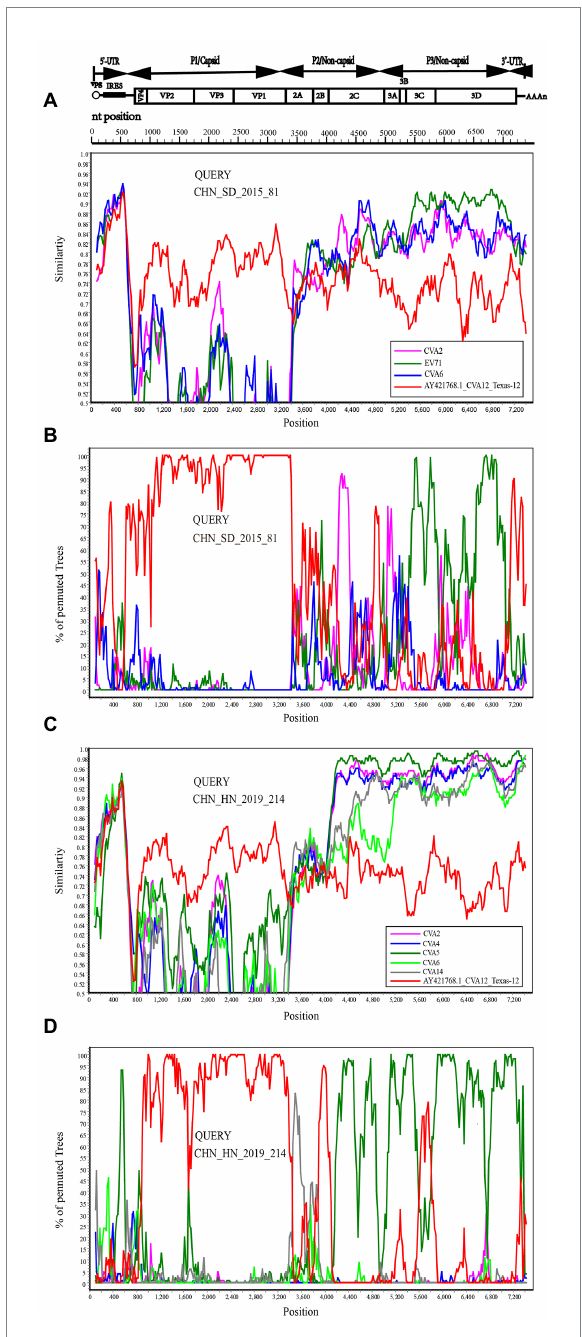
FIGURE 5 Recombination events of CHN_SD_2015_81 and CHN_ HN_2019_214 strains were investigated based on Similarity plots and bootscanning analyses. Panels (A,C) are the similarity diagram, and Panels (B,D) are the guided scan analysis. CHN_ SD_2015_81 and CHN_HN_2019_214 strains were used as query sequences (shown in black